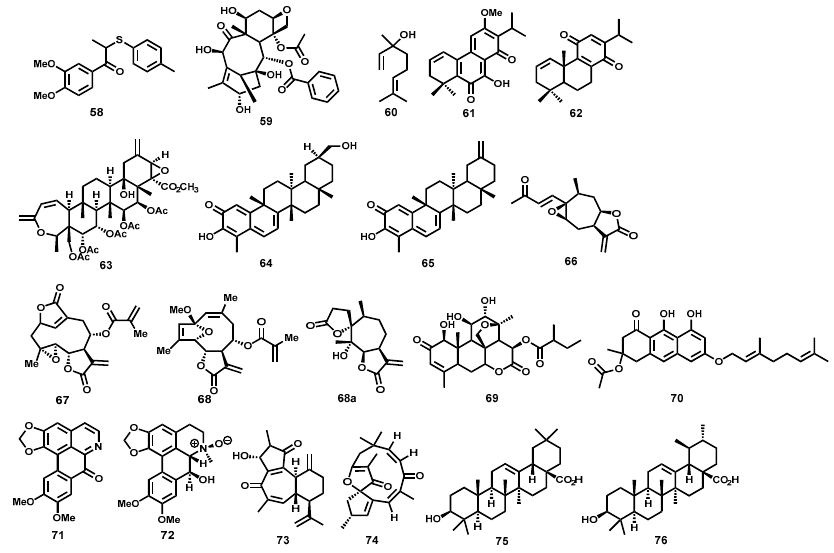
Figure 10. Lignans, taxoids, anthranoids, terpenes and other leishmanicidal